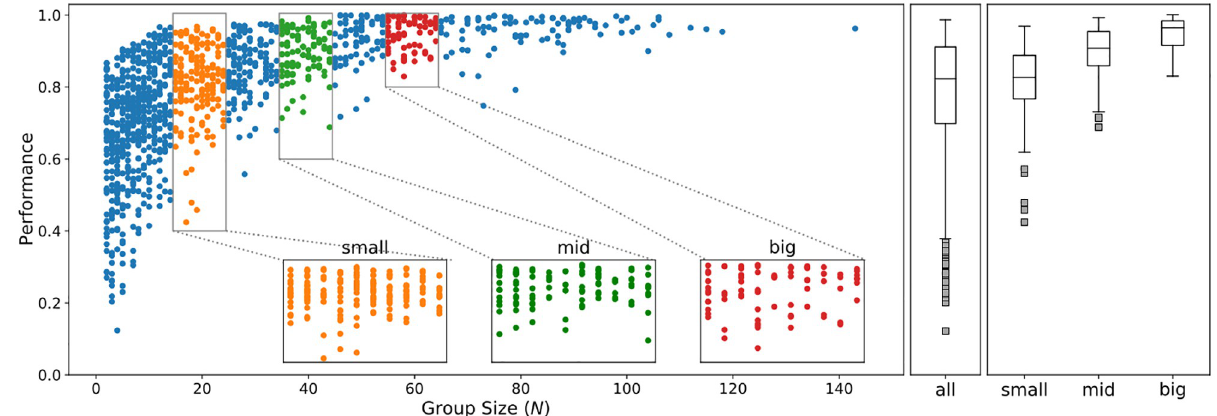
Fig 2. Splitting the sample of all teams (with 2 to 60 members) into four specific subsamples was a prerequisite for comparing the network patterns of teams of different sizes.